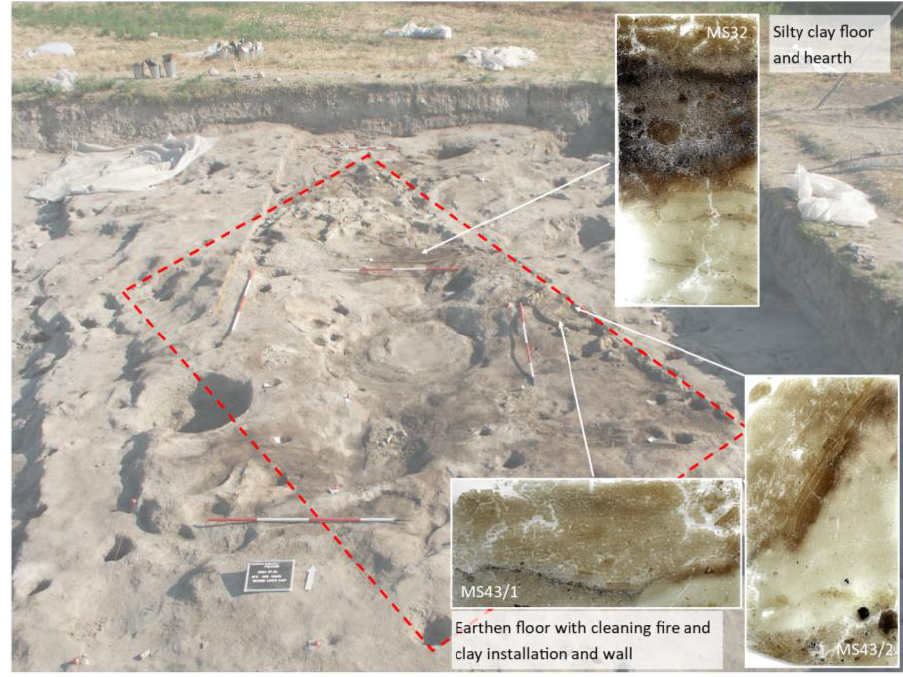
Figure 3. Basin-like clay feature (ID 3517) attached to the eastern wall of house ID 3497.